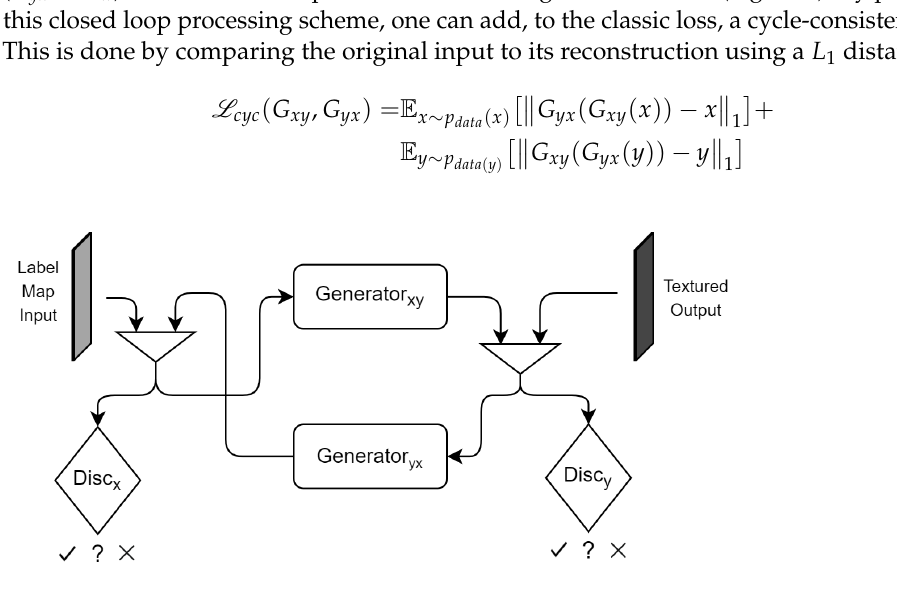
Figure 2. CycleGAN architecture